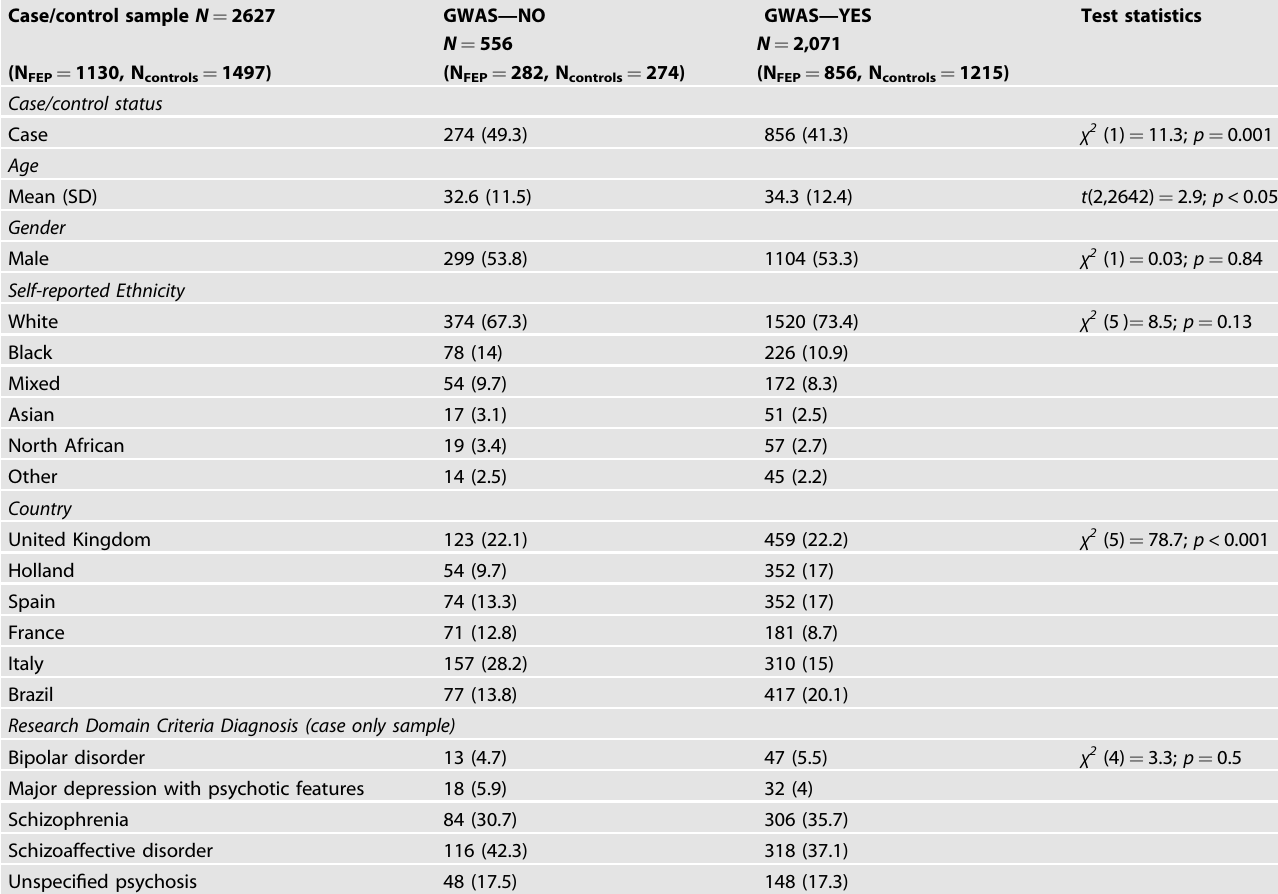
Table 1. Sociodemographic and clinical differences between genotyped and not-genotyped individuals. Case/control sample N =